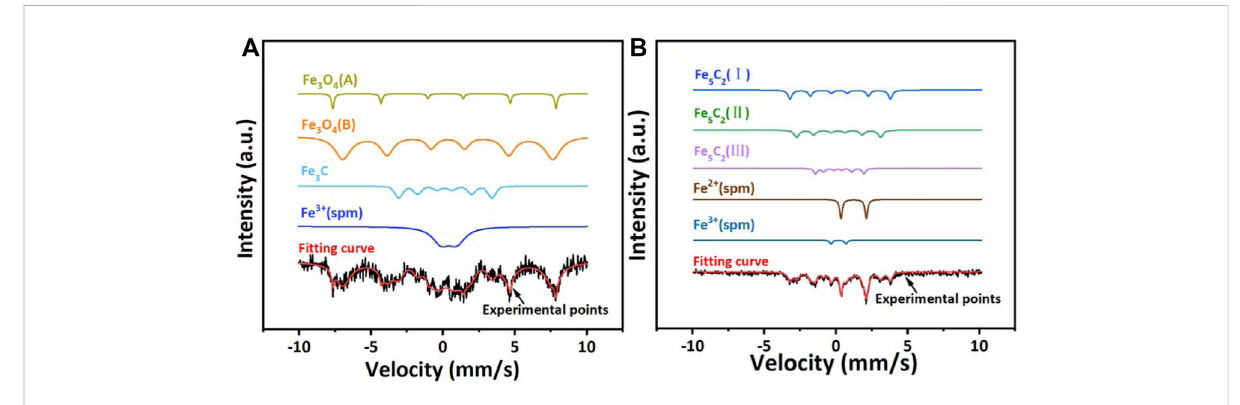
FIGURE 1 Mössbauer spectra of the (A) passivated MnCuK-FeC (B) spent